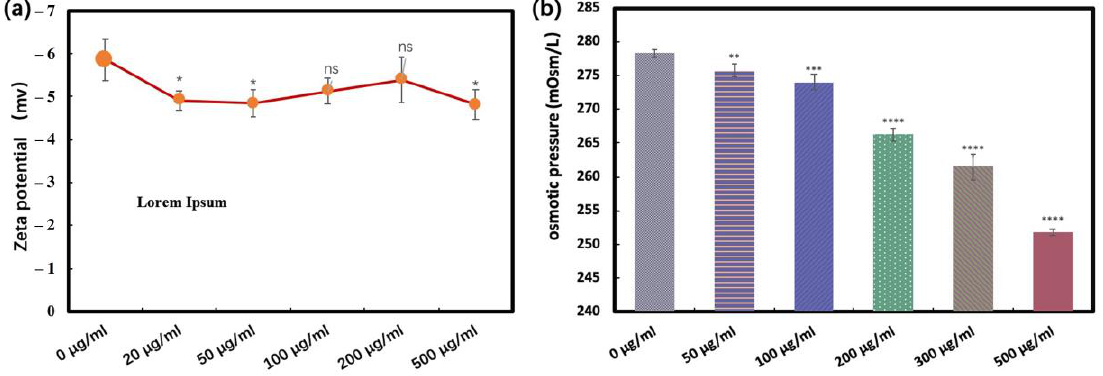
Figure 10. Zeta potential and osmotic pressure of CQD at different concentrations. ( a ) Zeta potential and ( b ) osmotic pressure (n.s. p > 0.05, * p < 0.05, ** p < 0.01, *** p < 0.001, and **** p <